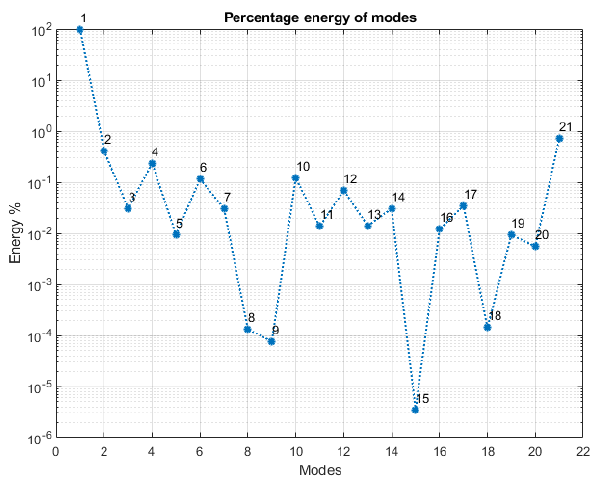
Table 4. Detail of the chosen mode shapes.